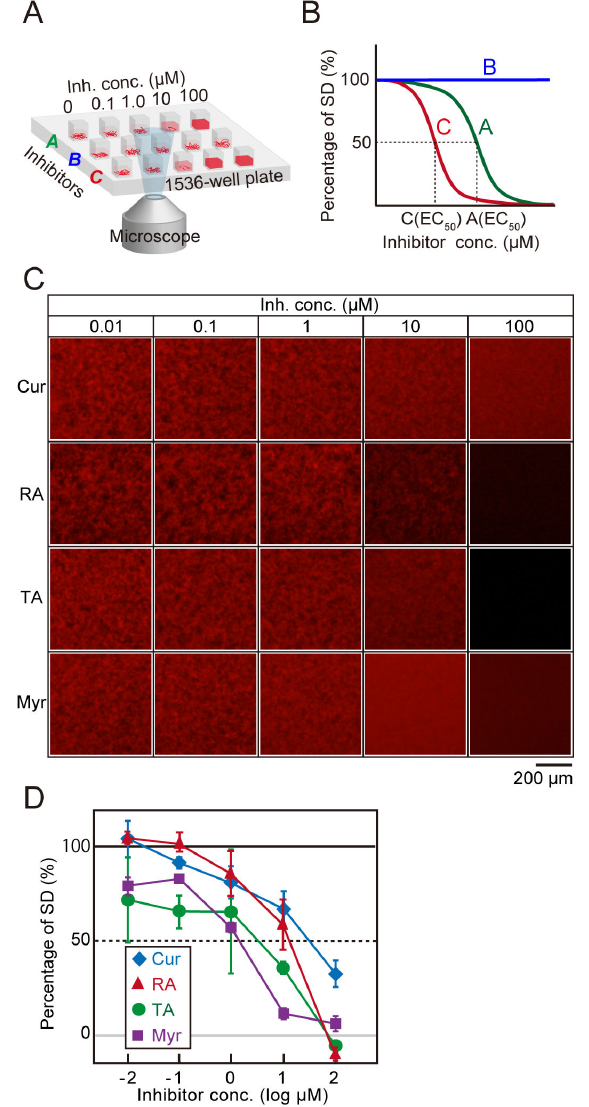
Figure 7. Estimation of EC by the microliter-scale high- 50 throughput screening system. (A) A schematic illustration of a microliter-scale high-throughput screening system for three samples. (B) The concept of estimation of EC values from 50 inhibition curves that are a plotted percentage of SD versus concentrations of inhibitors. The EC of sample A is higher 50 than that of sample C, and sample B did not inhibit Aβ aggregation. (C and D) Estimations of EC of well-known 50 inhibitors, curcumin (Cur), rosmarinic acid (RA), tannic acid (TA), and myricetin (Myr). 30 nM QDAβ and 30 µM Aβ was 42 incubated with various concentrations of the four inhibitors at 37 ° C for 24 h (C). The SD values from the fluorescence images plotted against several concentrations of inhibitors (D). Error bars represent ±SDs of the mean values from fluorescence intensities (n=3 separate experiments). EC 50 values of Cur, RA, TA, and Myr were 31 ± 16, 11 ± 2, 1.8 ±